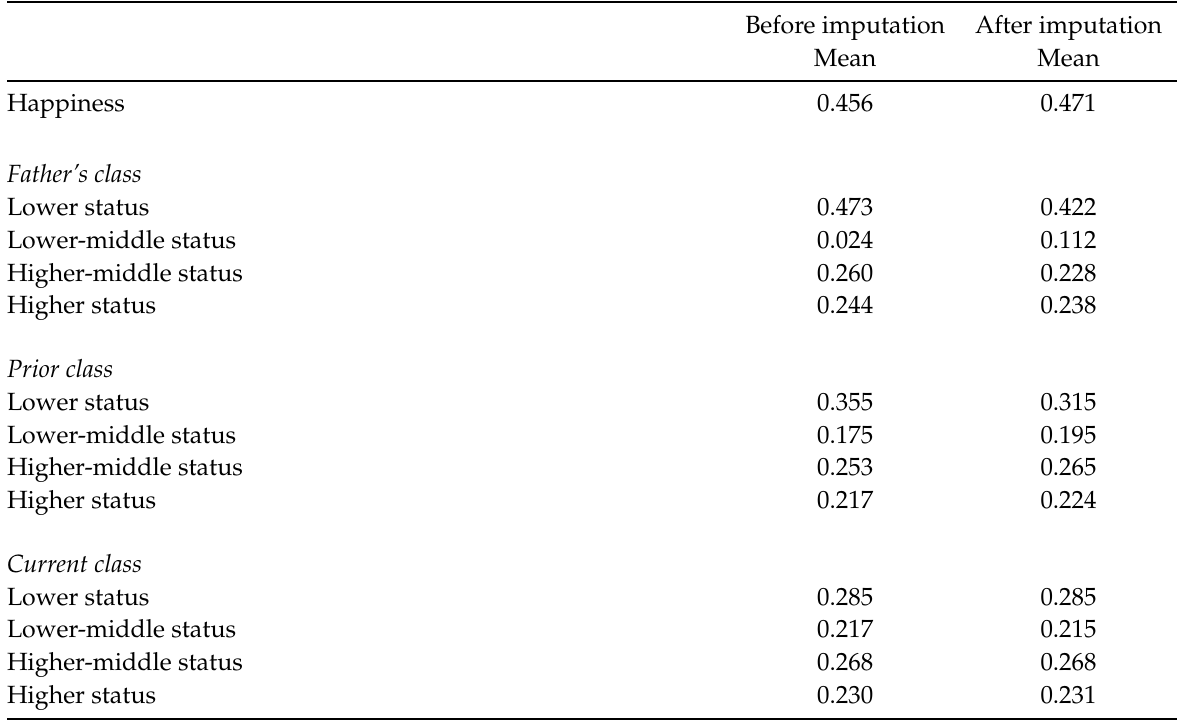
Table 1: Variable descriptive